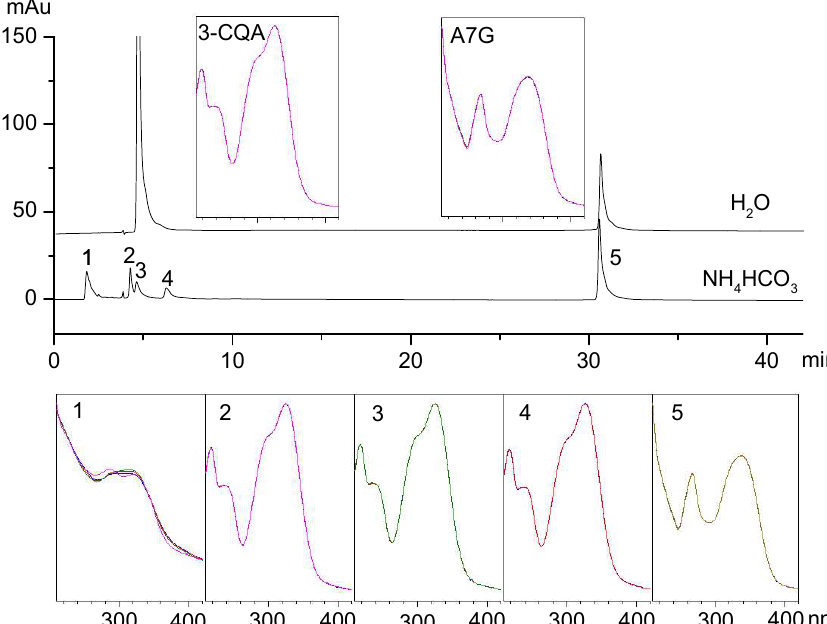
Figure 3. HPLC and UV analysis of the hydrolysates of 3-CQA and A7G treated with ammonium hydrogen carbonate. The UV spectrum is from a scan from 210 to 420 nm.